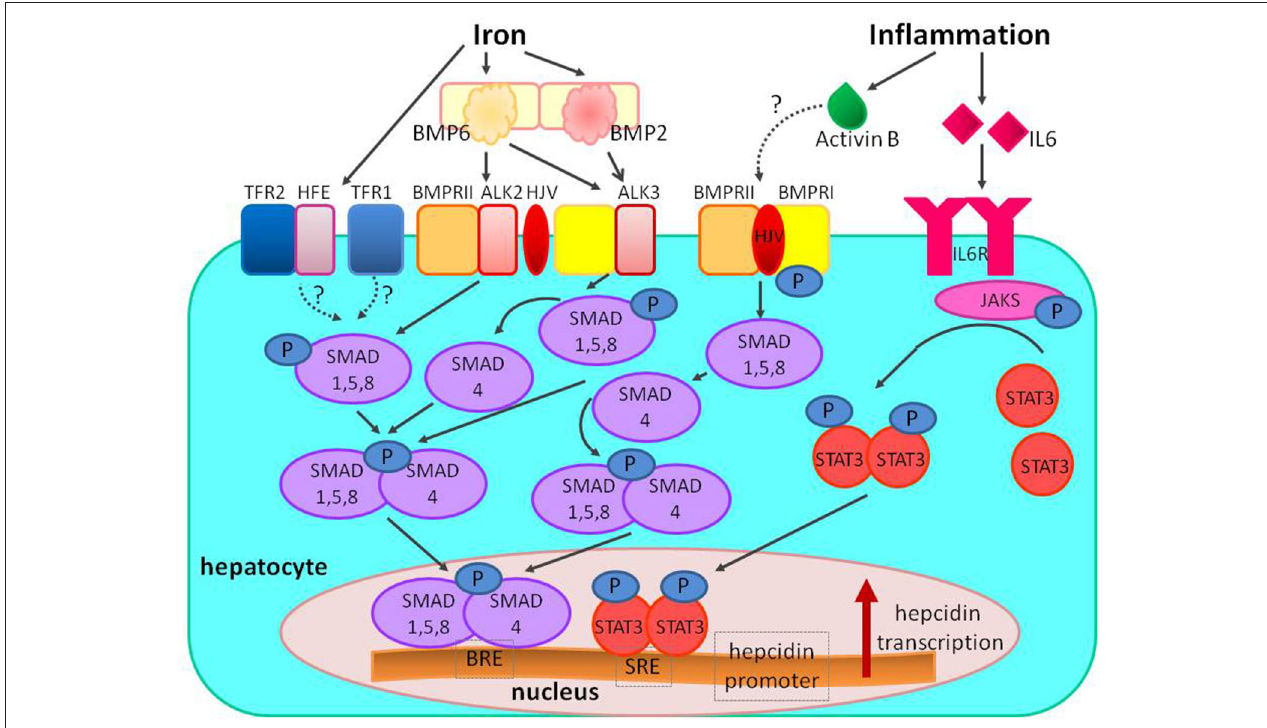
FIGURE 5 | The regulation of hepcidin expression by iron and inflammation. Increased systemic iron stimulates the production of the ligand BMP6, which binds to the BMPRI (ALK2/ALK3) and BMPRII receptors, and the co-receptor HJV to stimulate phosphorylation of the SMAD1/5/8 signaling molecules; phosphorylated SMAD1/5/8 binds to SMAD4 and translocates to the nucleus to bind BRE in the hepcidin promoter. In iron overload diferric transferrin displaces HFE from TFR1 to enable iron uptake and stabilizes TFR2 potentiating SMAD signaling (the role of the other HFE and TFR2 proteins is still unclear). Inflammation also stimulates hepcidin production; inflammation increases IL-6 binding to IL-6R and stimulating phosphorylation of JAKs and STAT3; phosphorylated STAT3 homodimers translocate to nucleus and bind to SRE in hepcidin promoter. The proposed mechanism of interaction between inflammatory and BMP signaling includes activin B, which is induced by inflammation, and binds to BMPRs to stimulate SMAD1/5/8 phosphorylation. The interaction between SMAD and STAT can also take place at the level of hepcidin promoter. BMP, bone morphogenetic protein; BMPR, bone morphogenetic protein receptor; SMAD, suppressor of mothers against decapentaplegic proteins; JAK, Janus kinase; STAT3, signal transducer and activator of transcription; HJV, hemojuvelin; HFE, hemochromatosis protein; IL-6, interleukin 6; IL-6R, interleukin 6 receptor; TfR, transferrin receptor; BRE, BMP-responsive elements in the hepcidin promoter; SRE, STAT-responsive elements in the hepcidin promoter; P, phosphate.